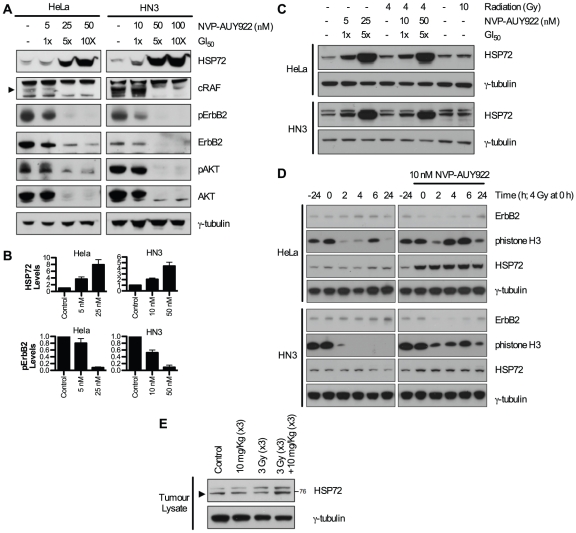
Molecular signature of NVP-AUY922 in combination with radiation.(A) To confirm depletion of HSP90 client proteins linked to radioresistance, levels were assessed in vitro in HeLa and HN3 cell lines by western blot. Cells were treated with vehicle only, or the concentrations of NVP-AUY922 indicated for 24 h, followed by reducing SDS-PAGE of 30 µg whole cell lysate and western blot detection of the HSP90 client proteins shown. (B) Levels of HSP72 28 h post NVP-AUY922 treatment and phospho-ErbB2 24 h post NVP-AUY922 treatment were determined by densitometry of three independent experiments (see Fig. S2A). (C) HeLa and HN3 cells were pre-treated with NVP-AUY922 for 24 h at the concentrations indicated. Cells were irradiated with 4 Gy or 10 Gy and 4 h later whole cell lysates harvested and probed for HSP72 by western blot. (D) Cells were pre-treated with 10 nM NVP-AUY922 for 24 h with 4 Gy of radiation delivered at the 0 hour time point. At the subsequent time points indicated, whole cell lysates were harvested and probed for total-ErbB2, phospho-histoneH3 and HSP72. (E) Tumor samples were harvested at the point of final irradiation to determine response to NVP-AUY922 in vivo. Tissue samples were homogenised and 30 µg of protein probed for HSP72 by reducing SDS-PAGE and western blot. γ-tubulin was probed as loading control in all blots shown.